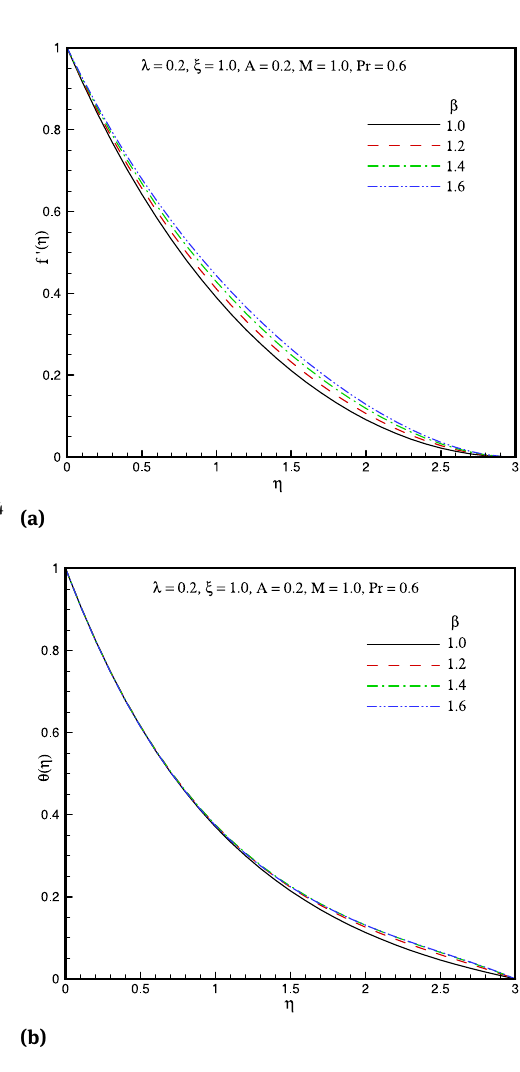
Figure 2: Simulated velocity and temperature profiles for various values of Deborah